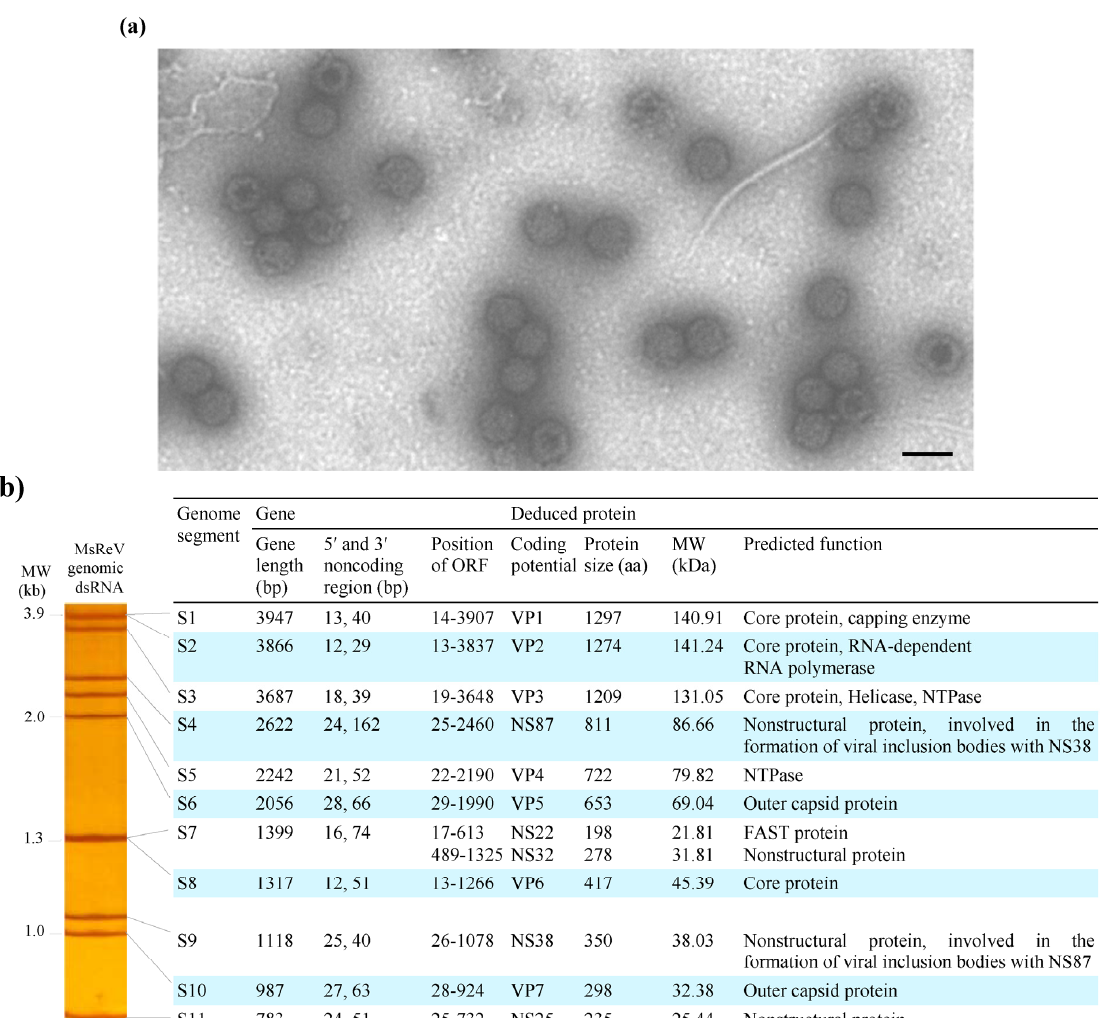
Figure 1. Morphology and genome organization of MsReV. ( a ) Electron micrograph of negatively stained MsReV particles. The virions are approximately 70–80 nm in diameter and have double-layered capsids. Bar = 100 nm; ( b ) Left panel, the electropherotype of MsReV genome segments; right panel, each genome segment and putative proteins of MsReV.